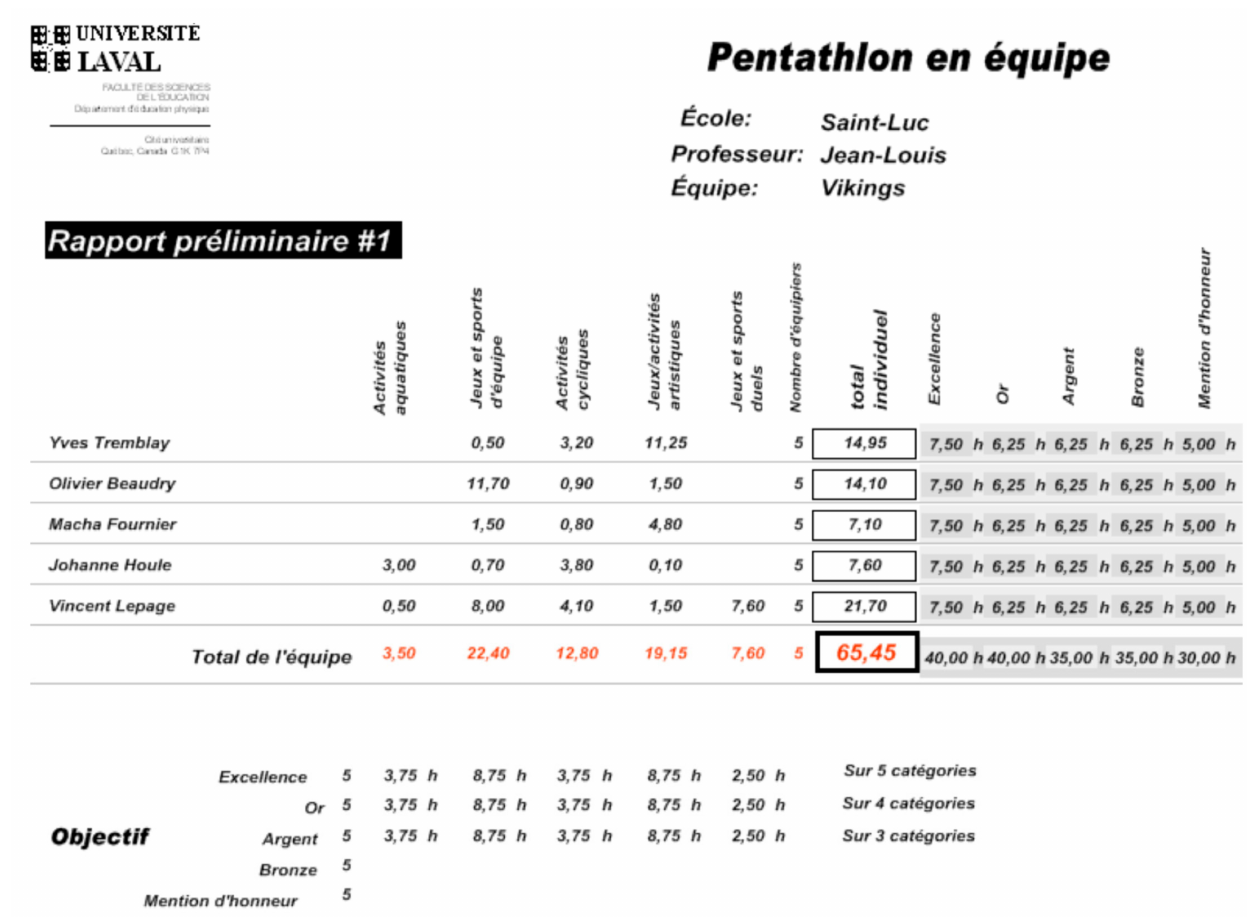
Figure A1. Names used in this table (student, school, teacher, team) are fictitious and are used as an example